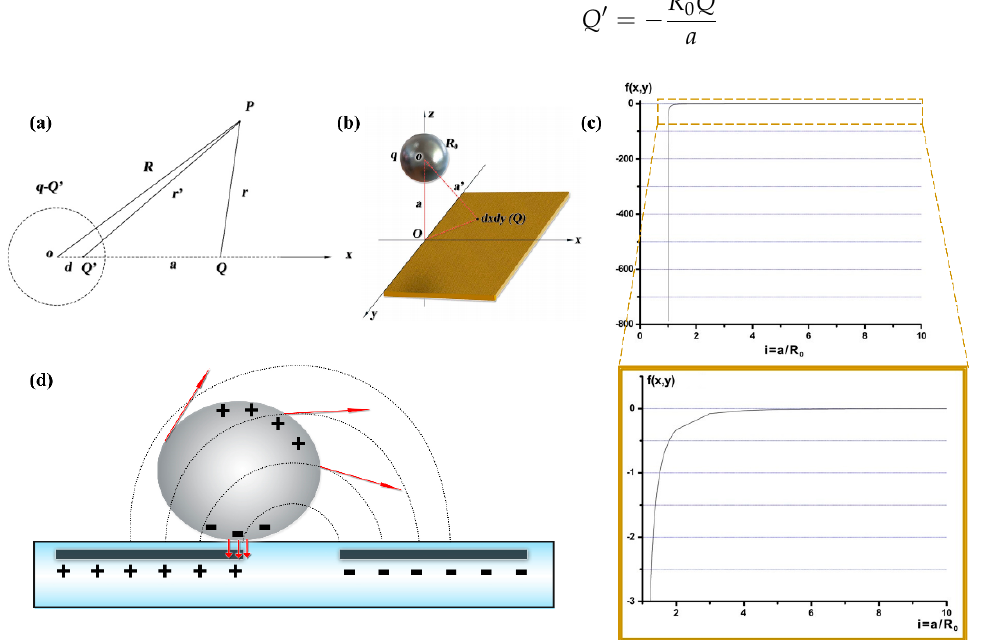
Figure 6. ( a ) Geometrical model of theoretical analysis; ( b ) geometric model of copper board electrode and LM droplet; ( c ) calculation result of forces on LM droplet from charged board with different droplet-board distance; ( d ) induced charge in a LM droplet inside electric field and schematic of droplet rolling principle.